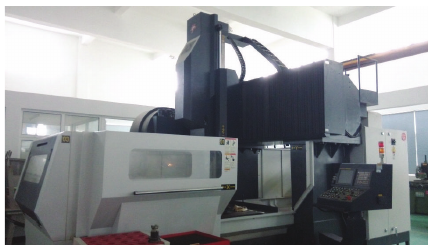
Figure 2: The FV-2215 horizontal Longmen machining center.